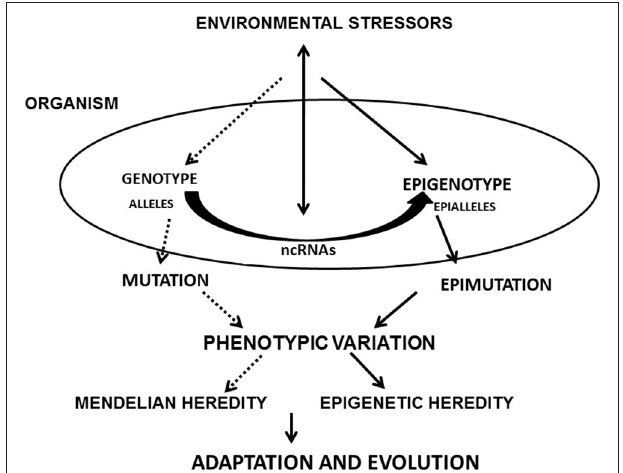
FIGURE 1 | Flow Diagram showing the paths where ncRNAs are involved in the development of phentopic variations and evolution: environmental stressors act on the epigenotype and genotype. ncRNAs receive and respond to these stimuli. These epigenetic influences, together with the effect of mutations and Mendelian inheritance originate new adaptations and evolutionary noveties would